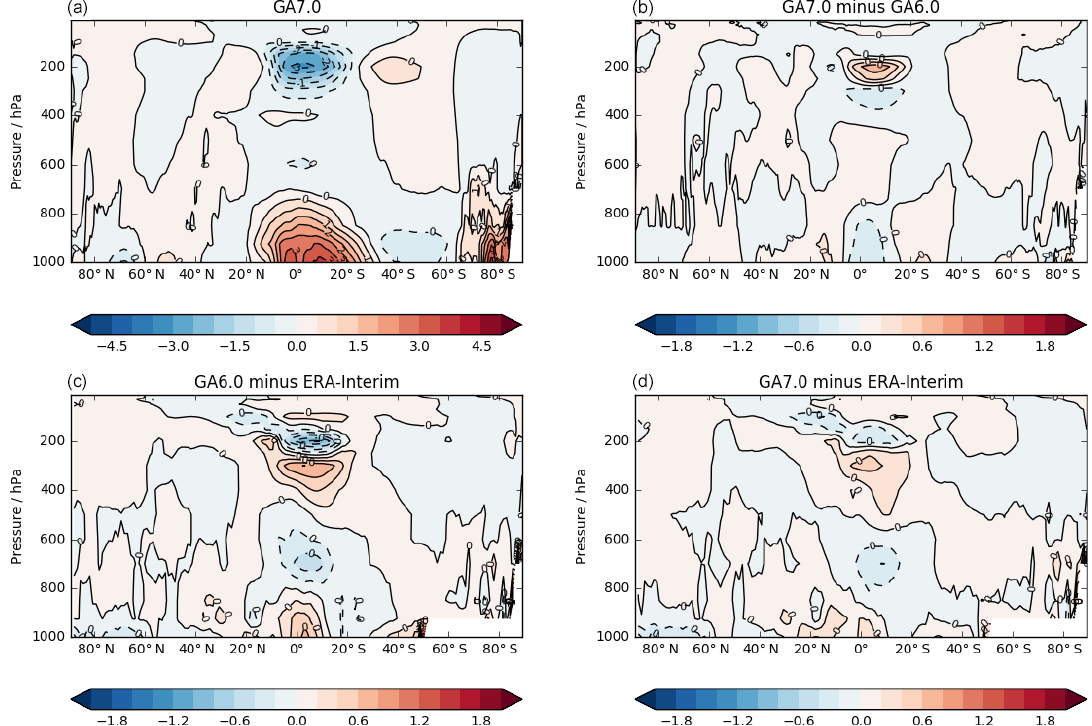
Figure 14. Zonal and time mean of the JJA meridional wind (ms − 1 ) in the N216 atmosphere/land-only climate simulations presented in Fig. 12 compared to ERA-Interim reanalysis. The layout is the same as in Fig.